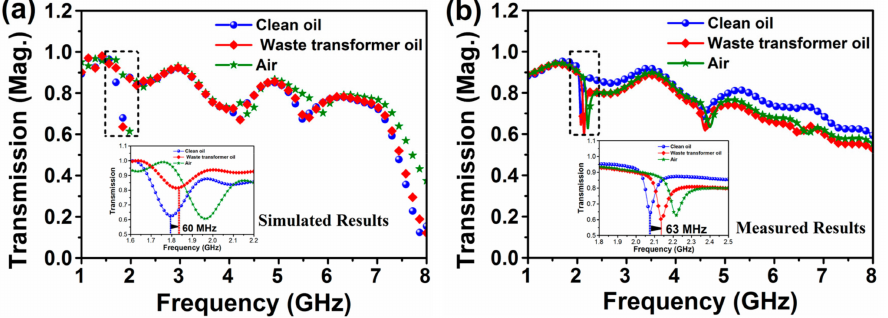
Figure 18. Transmission coe ffi cient for the clean and waste transformer oils at frequency 1–8 GHz ( a ) simulated result; ( b ) fabricated result.